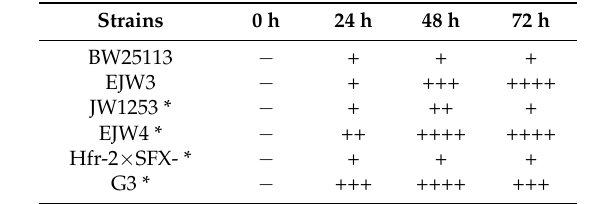
Table 3. Growth in aerobic condition in M9 supplemented with 0.75 M